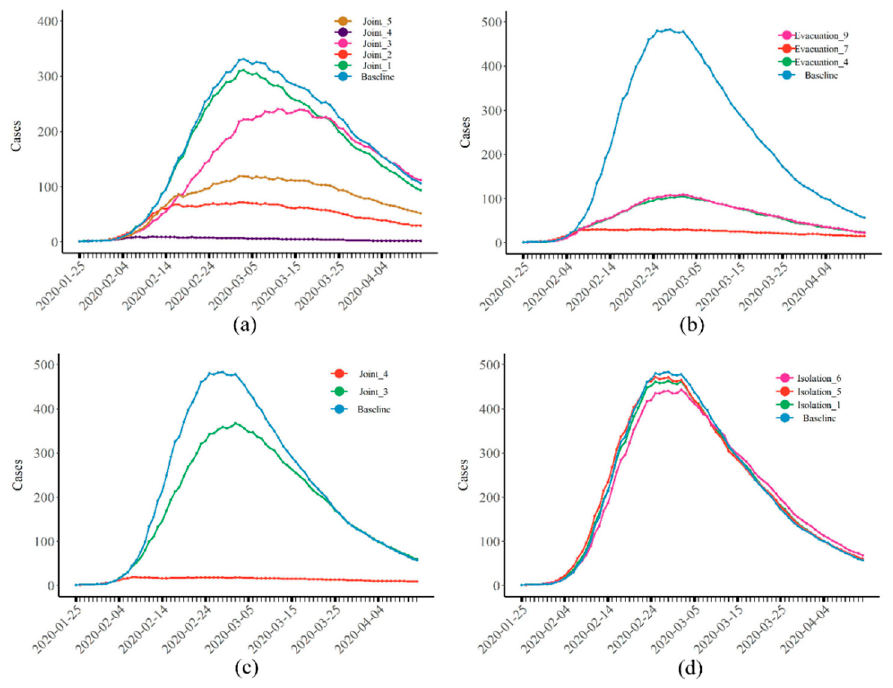
Figure 4. ( a ) The epidemic curves of COVID-19 when implementing joint interventions; ( b – d ) prevalence of infectious diseases after ( b ) isolation, ( c ) evacuation, and ( d ) joint intervention measures when the transmission rate increased by 50%. The number of all cases represents the sum of people infected that day, not the number of new cases.